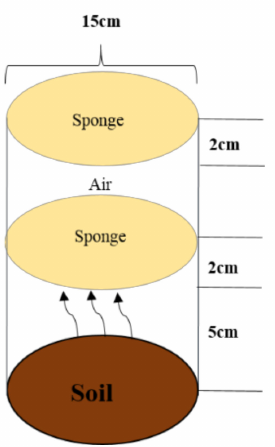
Figure 1. Venting method for determination of ammonia